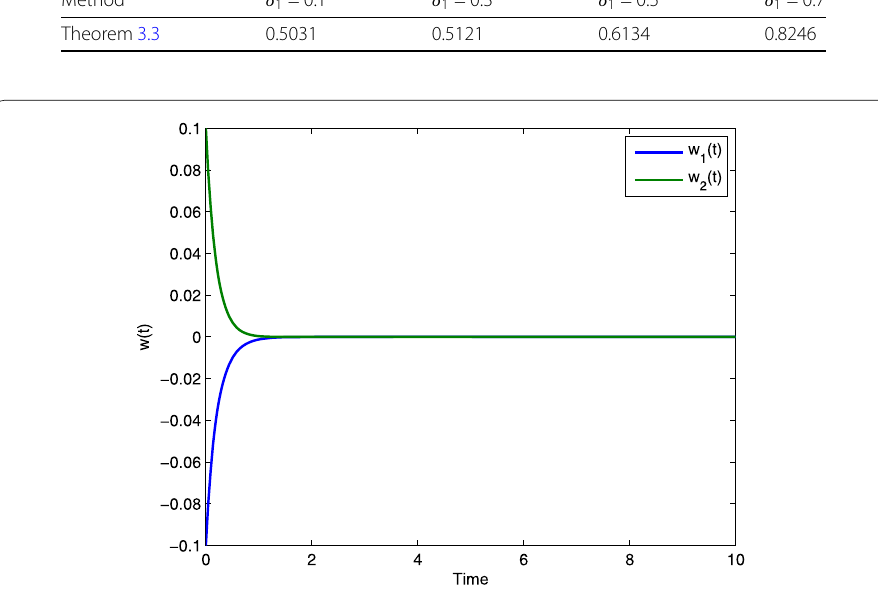
Figure 7 The trajectories of w 1 ( t ) and w 2 ( t ) with u ( t ) = 0 in Example 4.5